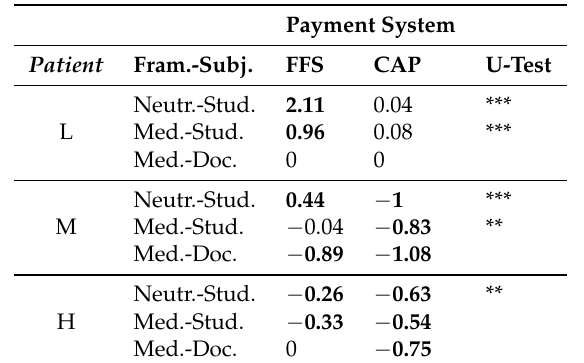
Table 8. Deviation from optimal treatment between fee for service and